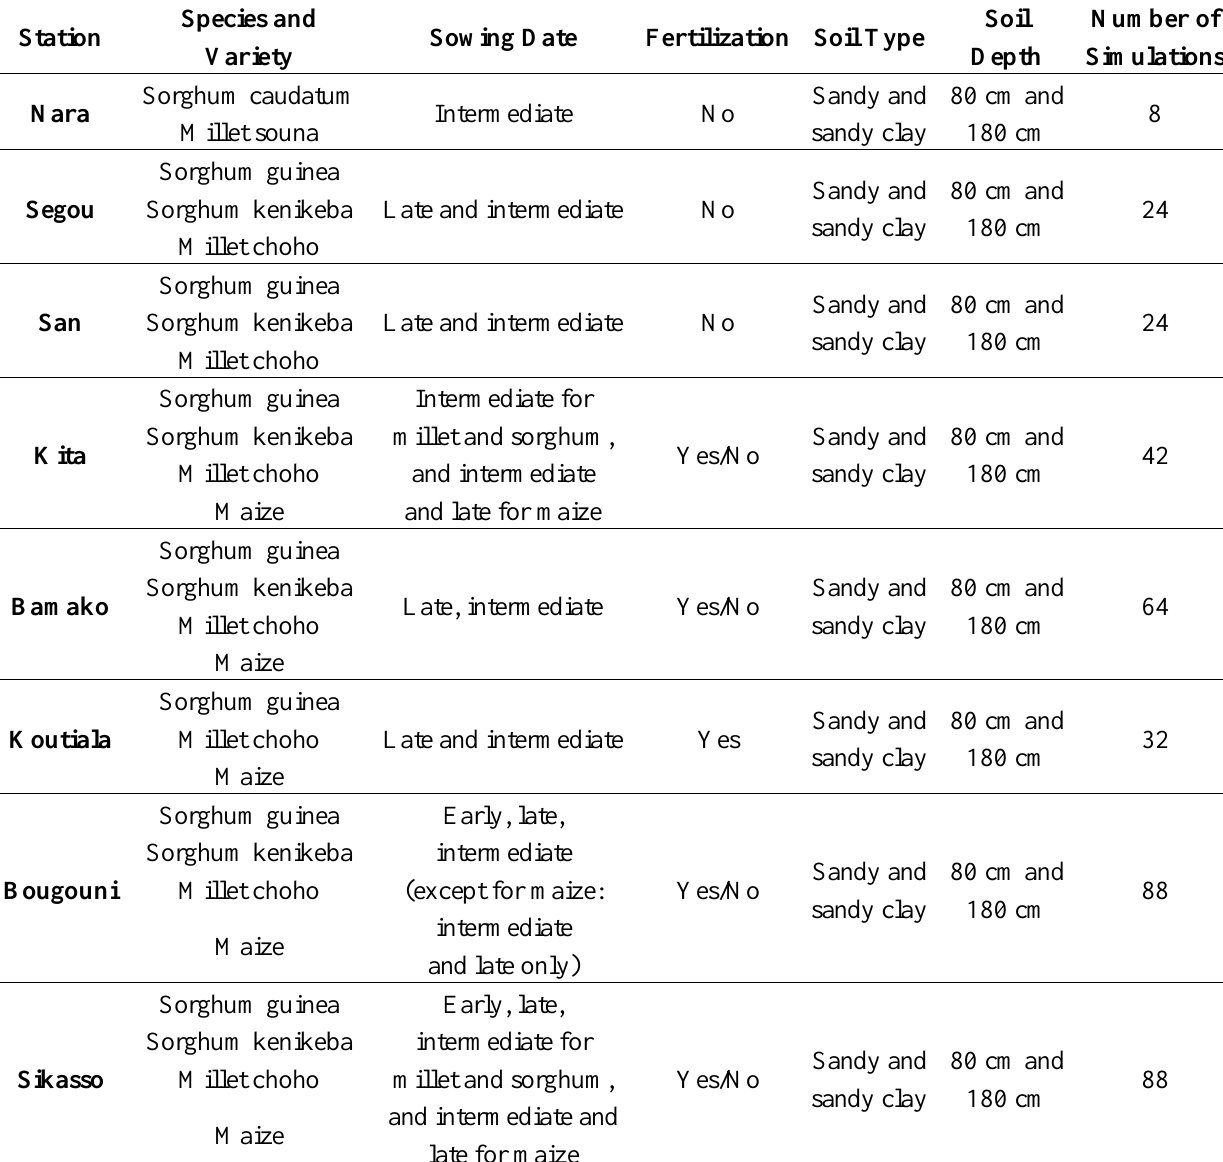
Table 3. System for Regional Analysis of Agro-Climatic Risks (SARRA-H) simulation input for each synoptic